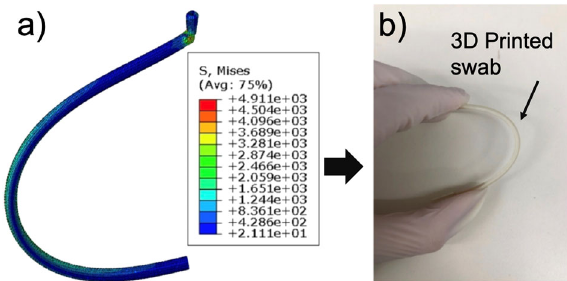
Fig. 6 Schematics. a Contour plot of the rod. b An actual bending test